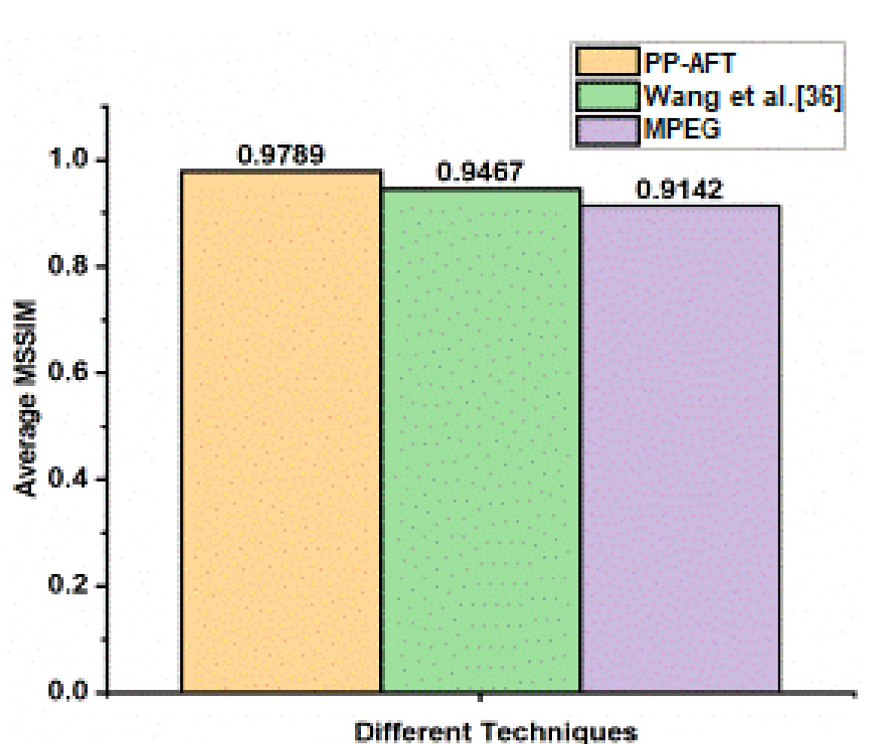
Fig 9. Average value of MSSIM for different techniques.